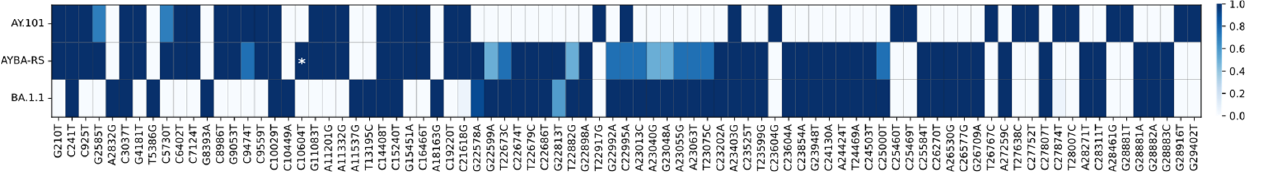
Figure A3. Recombination detection in the genome sequence of Brazil/RS-FIOCRUZ-8390/2022 (Sc2rf output). The analysis indicated that the 5’ region (positions 1–21,845) came from Delta, and the 3’ region (positions 21,846–29,903) came from an Omicron.